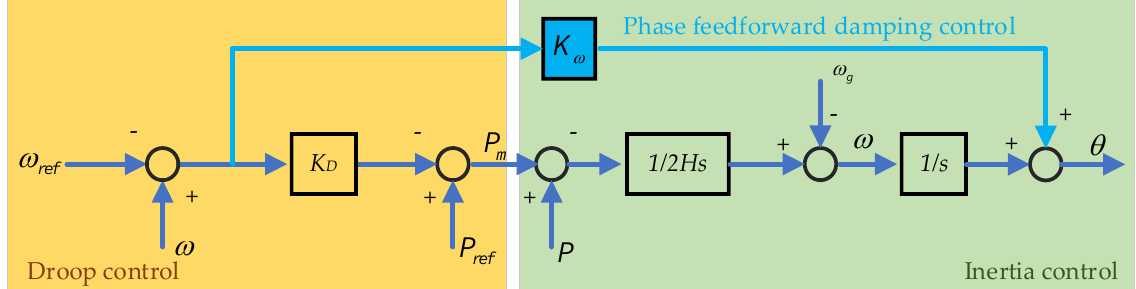
Figure 11. Active power control link of VSG with power feedback.